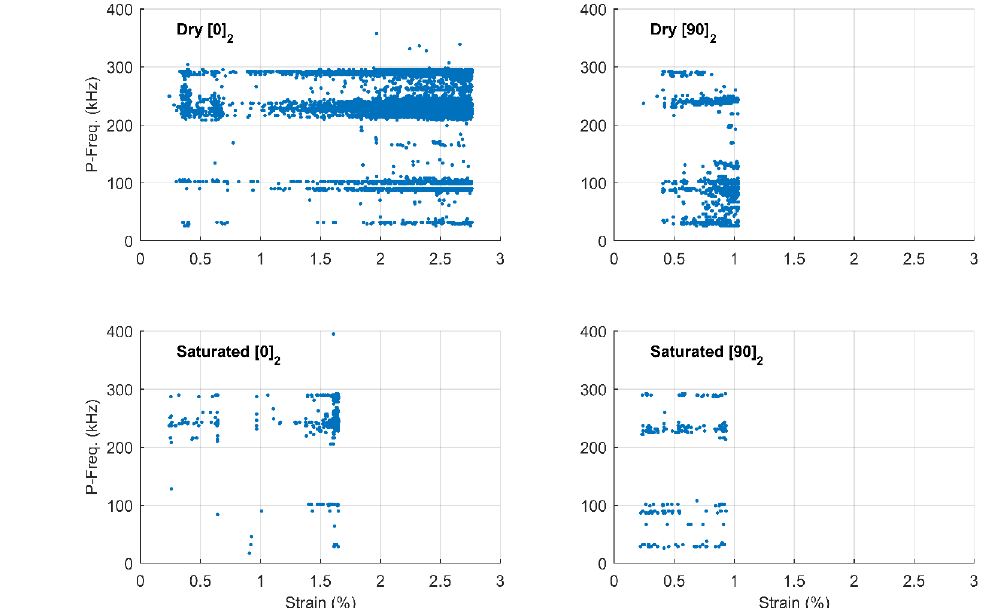
Figure 11. Typical event peak frequency versus strain for two-ply laminates.